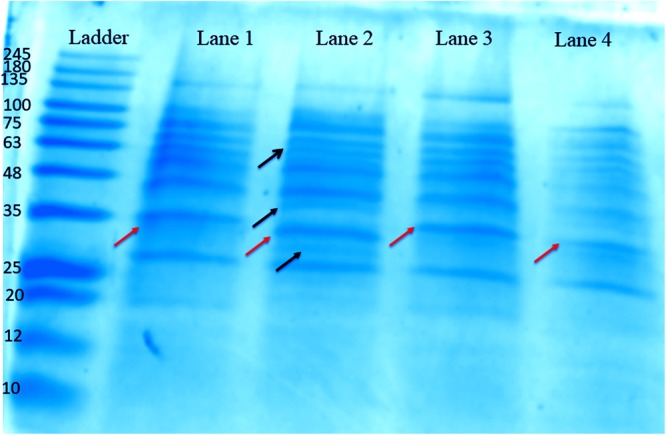
One-dimensional SDS-PAGE gel of proteins extracted from the biofilm matrices of representative high slime producing K. pneumoniae isolates from various samples grown in brain heart infusion (BHI) broth. Lane 1: Proteins from the matrix extract of stool isolate 197, harvested at 72 h. Lane 2: Proteins from the matrix extract of blood isolate 1739, harvested at 72 h. Lane 3: Proteins from the matrix extract of pus isolate 2884, harvested at 72 h. Lane 4: Proteins from the matrix extract of urine isolate 10894, harvested at 72 h. Ladder: MW protein marker ranging from 10 to 245 kDa. The orange arrows denote the common protein band (∼35 kDa), which we utilized for HPLC and MALDI analysis. However, the bands shown by black arrows are distinguished bands present in blood isolate 1739.